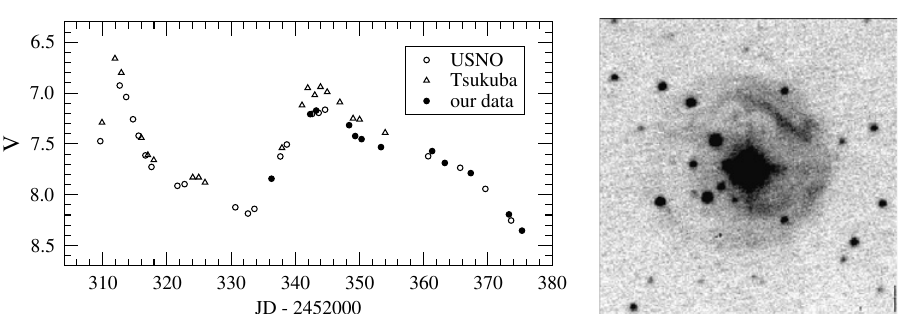
Fig. 1. On the left is the V light curve of the outburst of V838 Mon. Our data (solid dots) are compared with the published results (Munari et al. 2002). On the right is the light echo of V838 Mon. The image is the sum of five 30 s I -band exposures, obtained on April 1,